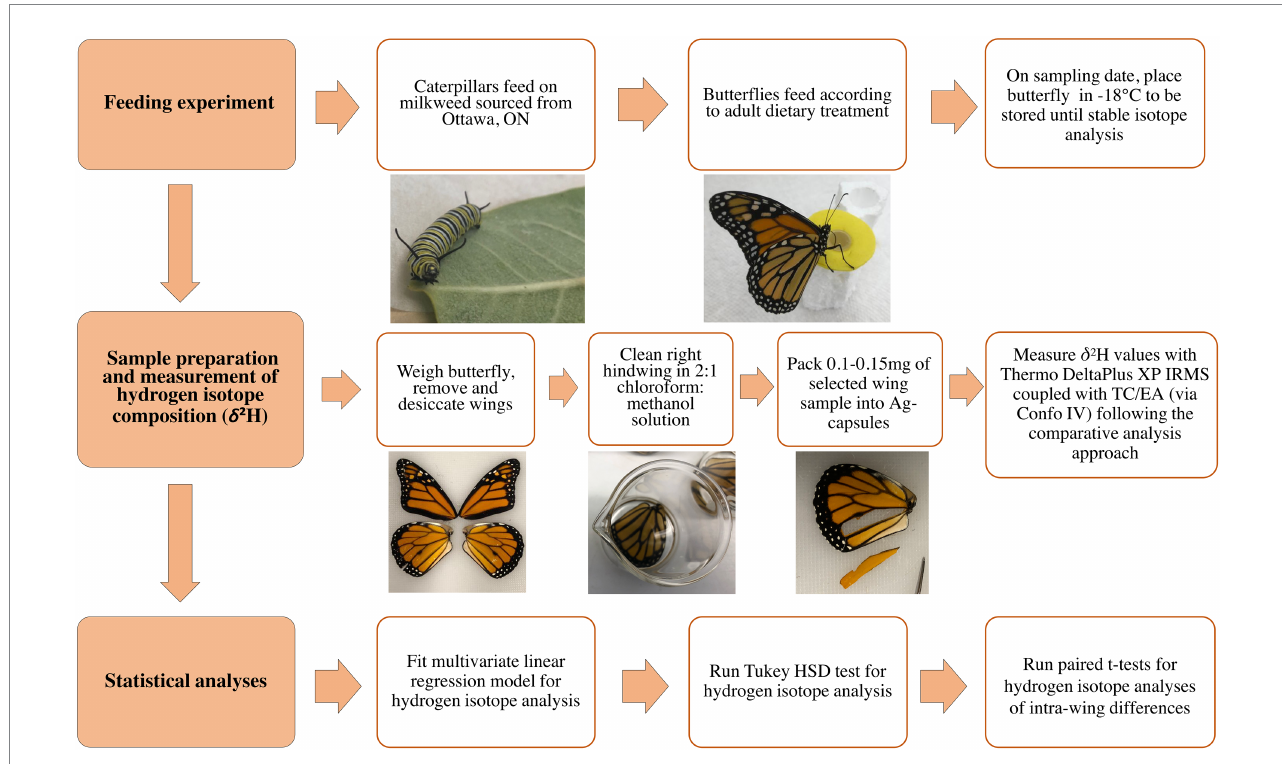
FIGURE 1 Flow chart summarising the methodology used in this study into three main stages with sub-steps depicting the procedure used to rear monarch butterflies in the feeding experiment, prepare wing samples, measure δ 2 H and perform statistical